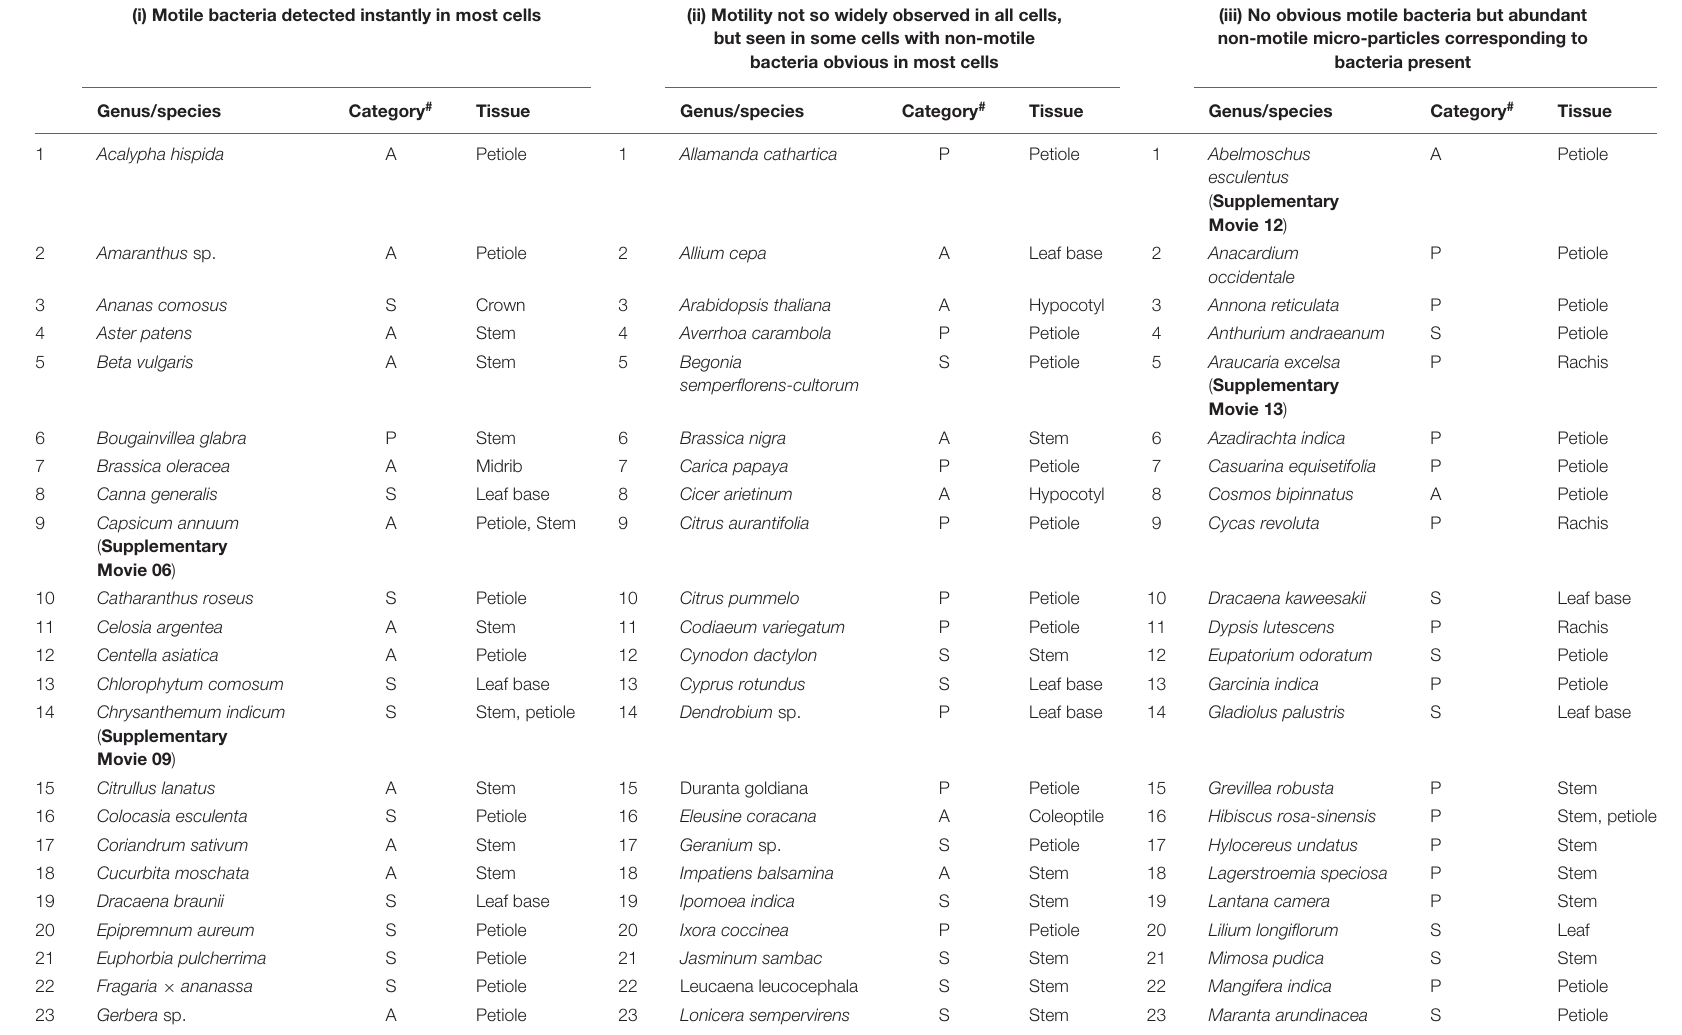
TABLE 1 | List of plant species taken up for the bright-field microscopy-based survey for endophytic bacteria and an empirical classification of plants based on the ease of observing motile intracellular bacteria in fresh tissue sections. (i) Motile bacteria detected instantly in most cells (ii) Motility not so widely observed in all cells,